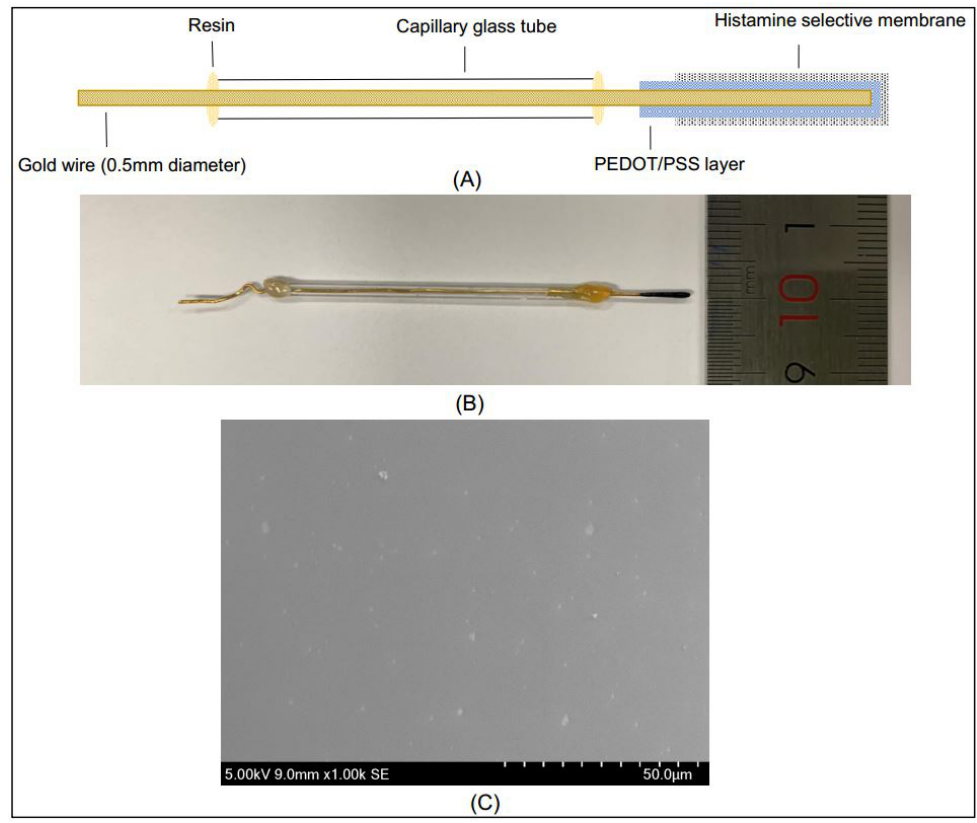
Figure 1. ( A ) Structure of solid-contact histamine ISE; ( B ) Photography of solid-contact histamine ISE (one centimeter ruler as a reference); ( C ) SEM image of histamine ion-selective